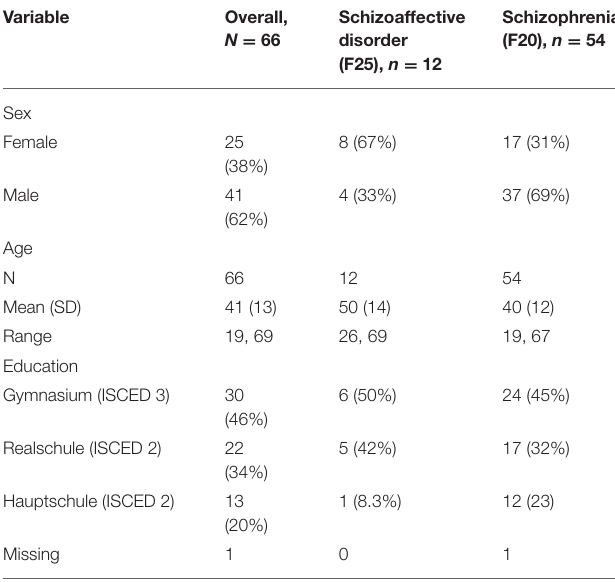
TABLE 1 | F2-Diagnoses and demographic data of the sample.